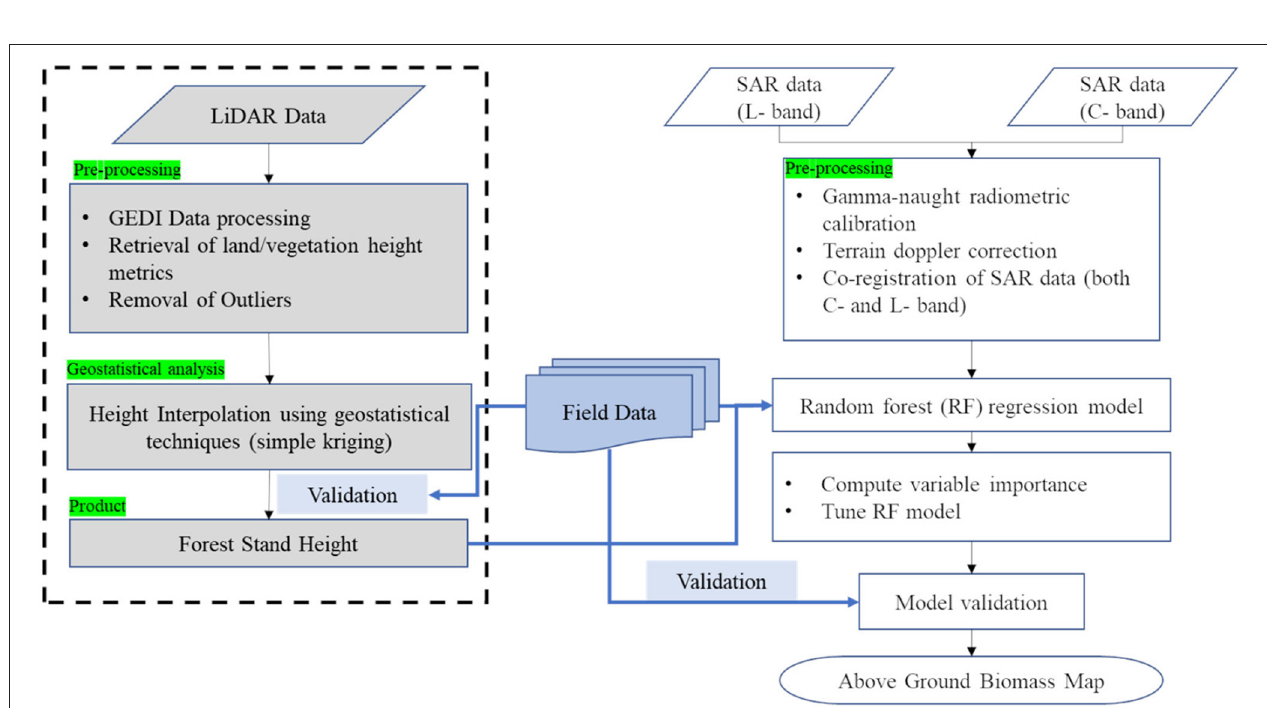
FIGURE 3 | Flow chart showing the approach followed in the development of multi-frequency SAR and multi-temporal LiDAR data based AGB models.